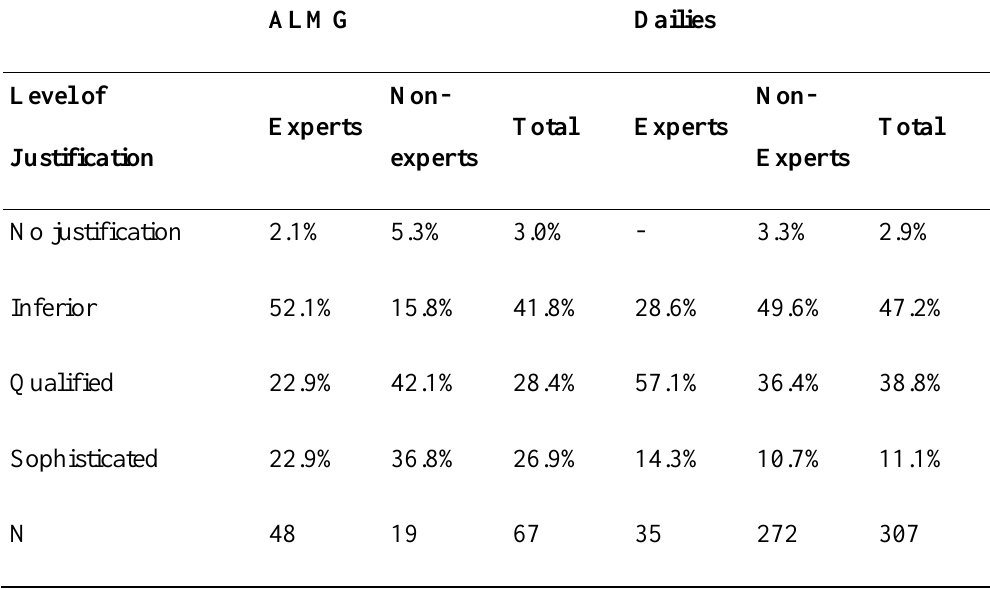
Table 6: Justification levels by experts and non-experts in each type of setting ALMG Dailies Level